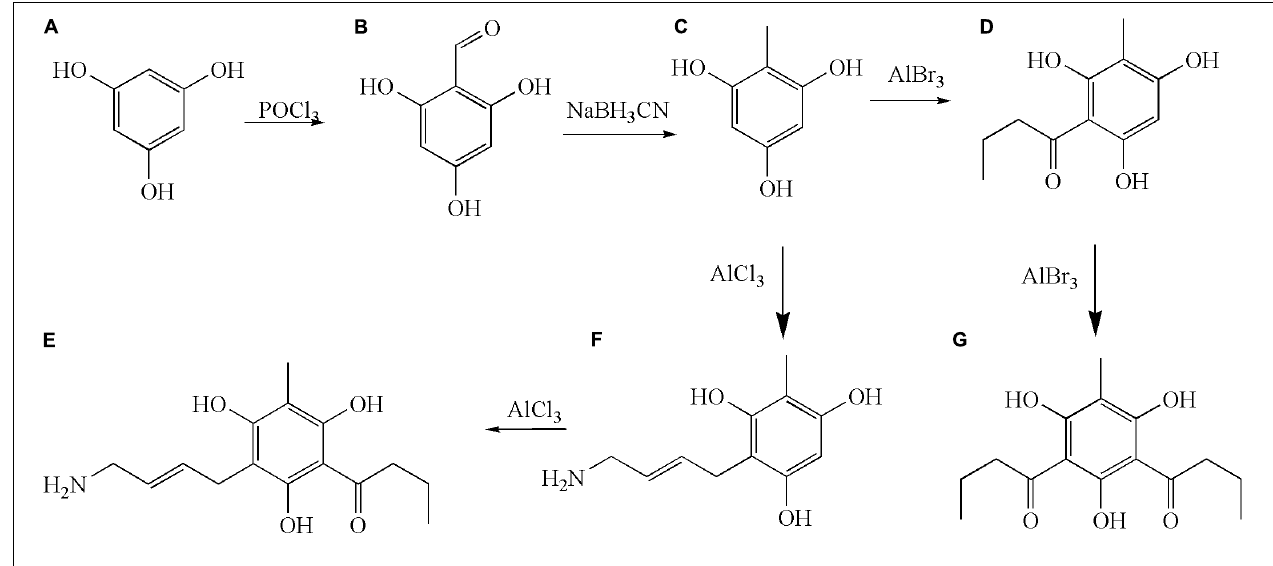
FIGURE 1 | Synthetic route of target